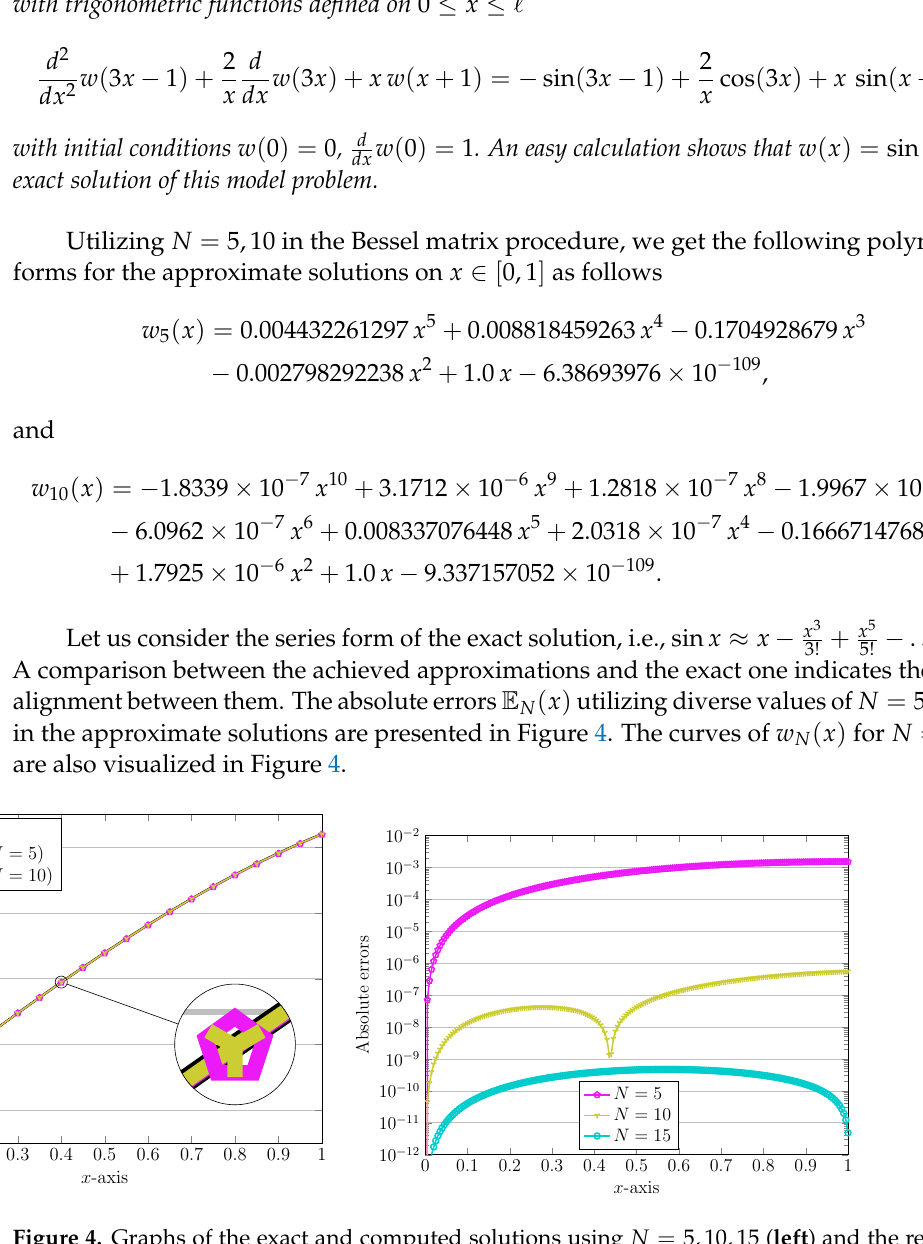
Figure 4. Graphs of the exact and computed solutions using N = 5,10,15 ( left ) and the resulting absolute errors ( right ) for (cid:96) = 1 in Example